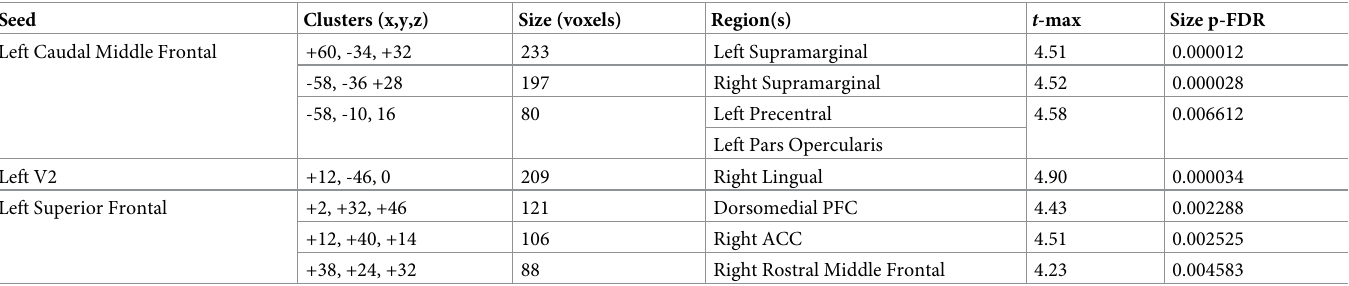
They also found several other clusters of cortical thinning, but the only a cluster on the occipi- tal temporal junction passed multiple comparison correction. We did not detect thinning in the occipital temporal junction as in our cohort. The discrepancy could be due to differences between Chinese and international chess or subject demographics. Most of these 10 regions with reduced cortical thickness can be linked to processes that reflect the obvious mental demands of the game of chess: mental imagery, visuospatial process- ing, and working and episodic memory. However, there also seems to be a common thread of motor-related regions (motor planning, visuomotor attention) that are affected by chess train- ing. It has been shown that physical actions can enhance performance in certain memory tasks [17, 18], and the question of the relationship between motor systems and higher cognition (sometimes called “motor cognition”) has recently gained interest [19]. It may be that the act